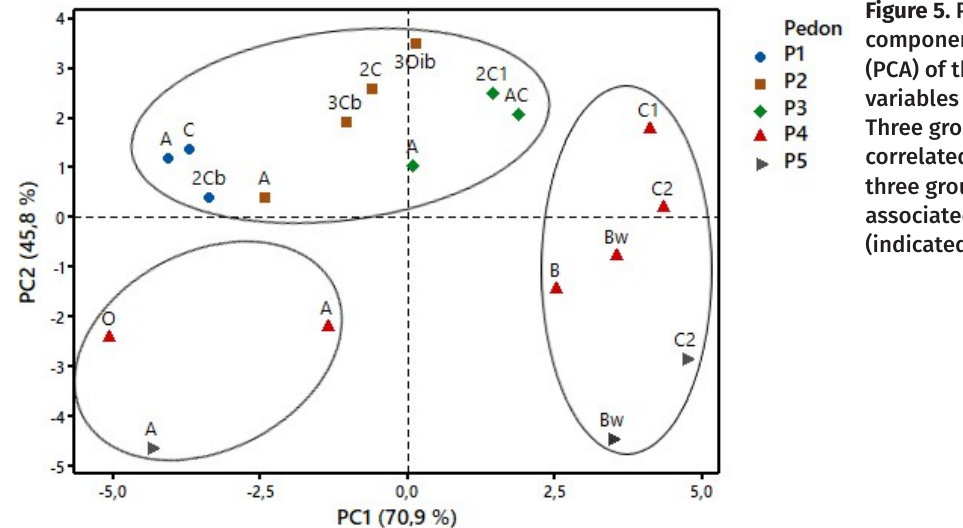
Figure 5. Principal component analysis (PCA) of the soil variables analysed. Three groups of correlated variables and three groups of samples associated with them (indicated by